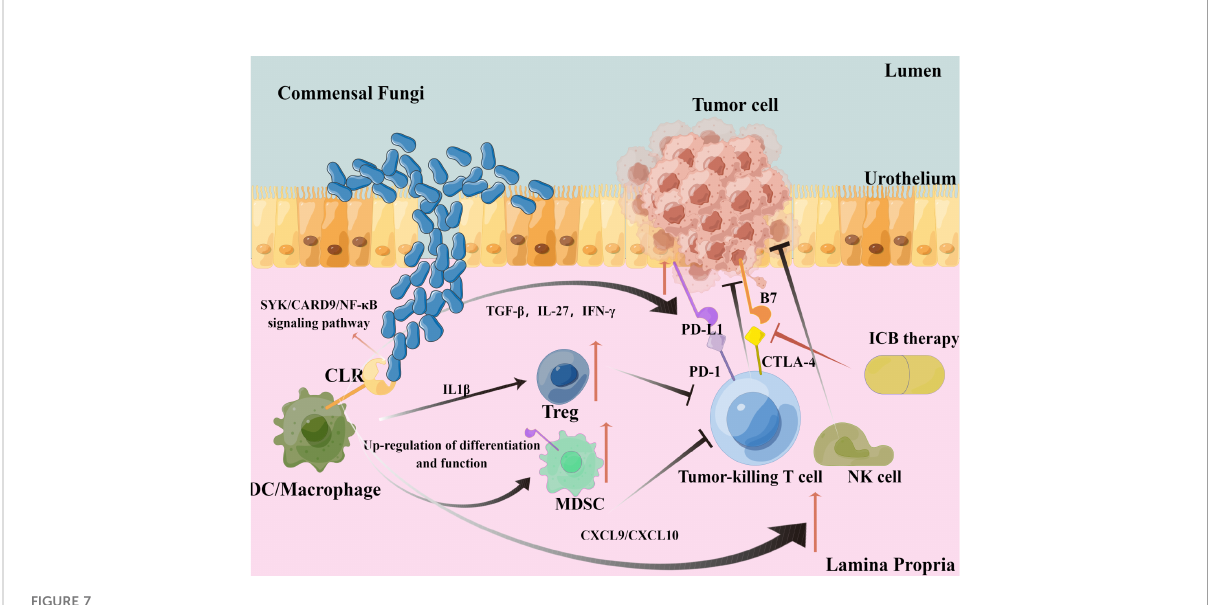
FIGURE 7 Graphical representation of our hypothesis and